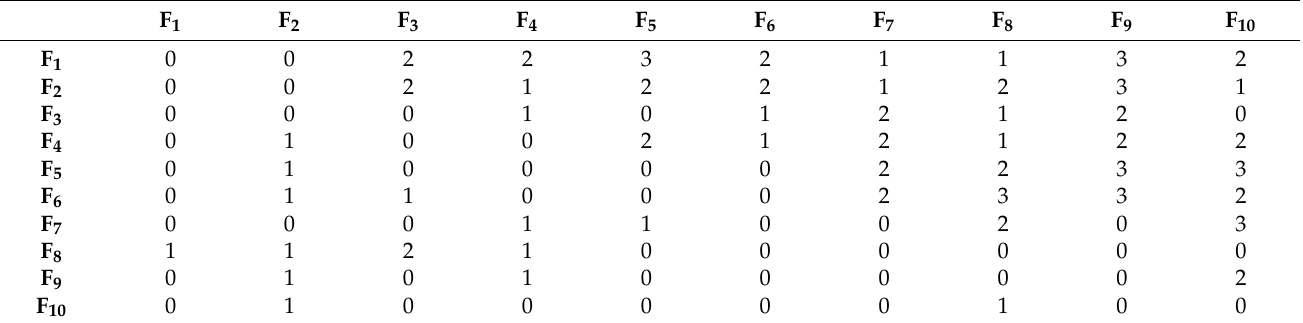
Table 12. The strength of the influence of SCF.